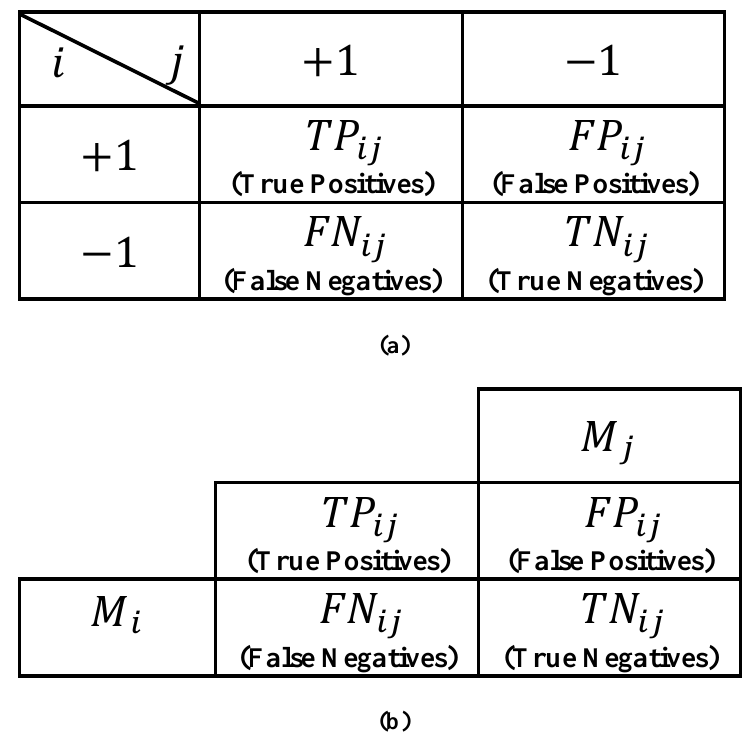
Fig. A1. The two-by-two Contingency Matrix (a) of test or metric 𝑖 with respect to test or metric 𝑗 viewed as a two-variable Karnaugh map (b) representing a pseudo-Boolean